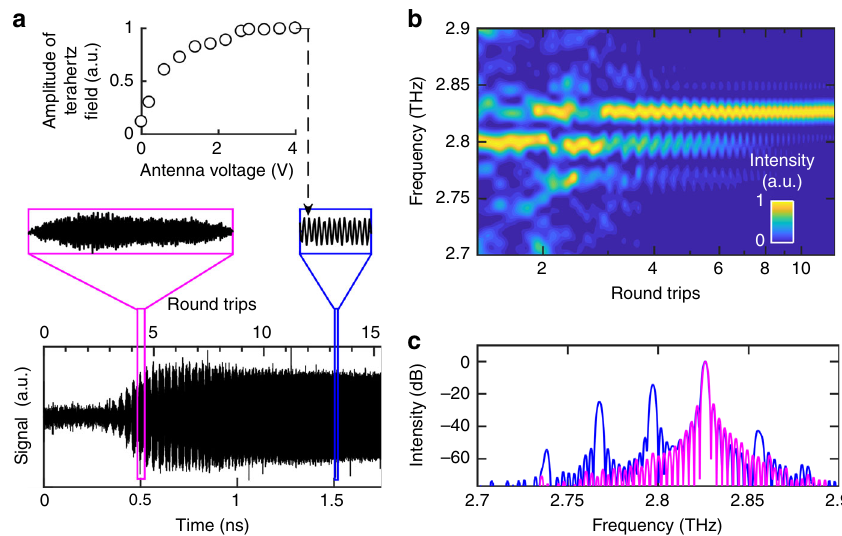
Fig. 3 Coherent time-domain measurement of the electric fi eld emitted from the coupled-cavity laser with the tuning cavity switched off. a The electric fi eld emitted from the output facet of the tuning cavity, measured as a function of time. The seed pulse enters the laser cavity at t = 0. The lasing cavity is driven using quasi-direct current pulses of amplitude 0.65 A and the tuning cavity is switched off. Inset: Close-up of the measured electric fi eld and the variation of the amplitude of the terahertz fi eld at t = 1500 ps as a function of voltage applied across the broadband photoconductive antenna. An increase in the terahertz fi eld was measured with respect to antenna bias, before saturating at an antenna bias >2.5 V implying that the emission is fully injection seeded by the seed pulse. b Plot showing the dynamic variation of the emission spectra, obtained from the fast Fourier transform of the time-domain electric fi eld using a moving time window of width 150 ps. The x -axis plots the beginning of this time window on a logarithmic scale to emphasise the presence of mode hopping during the initial few round-trips in the cavity. c Emission spectra obtained from the fast Fourier transform of the time-domain electric fi eld using a ~460-ps-wide time window beginning at t = 400 ps (blue) and at 1700 ps